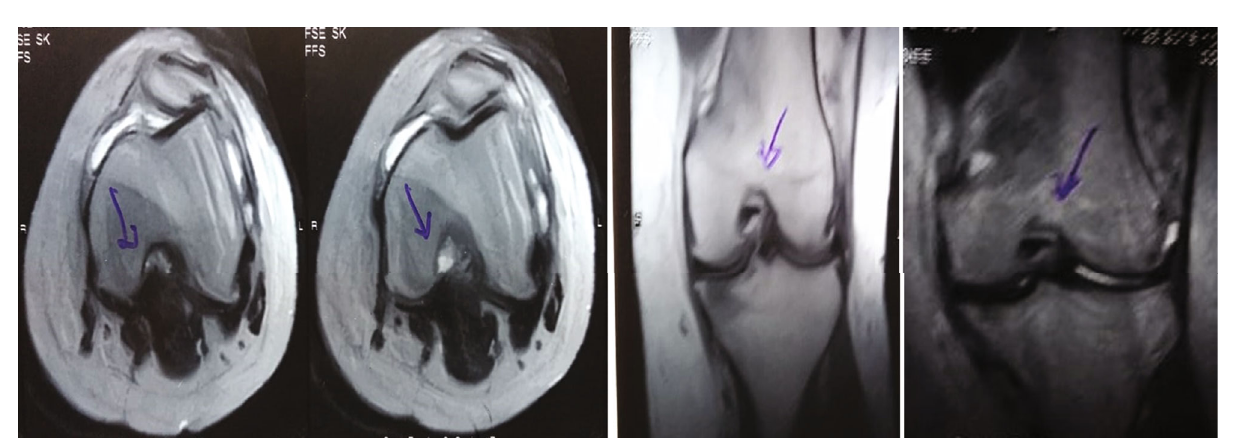
Figure 1: Pretreatment MRI showing grade III tear in the posterior horn of the medial and lateral